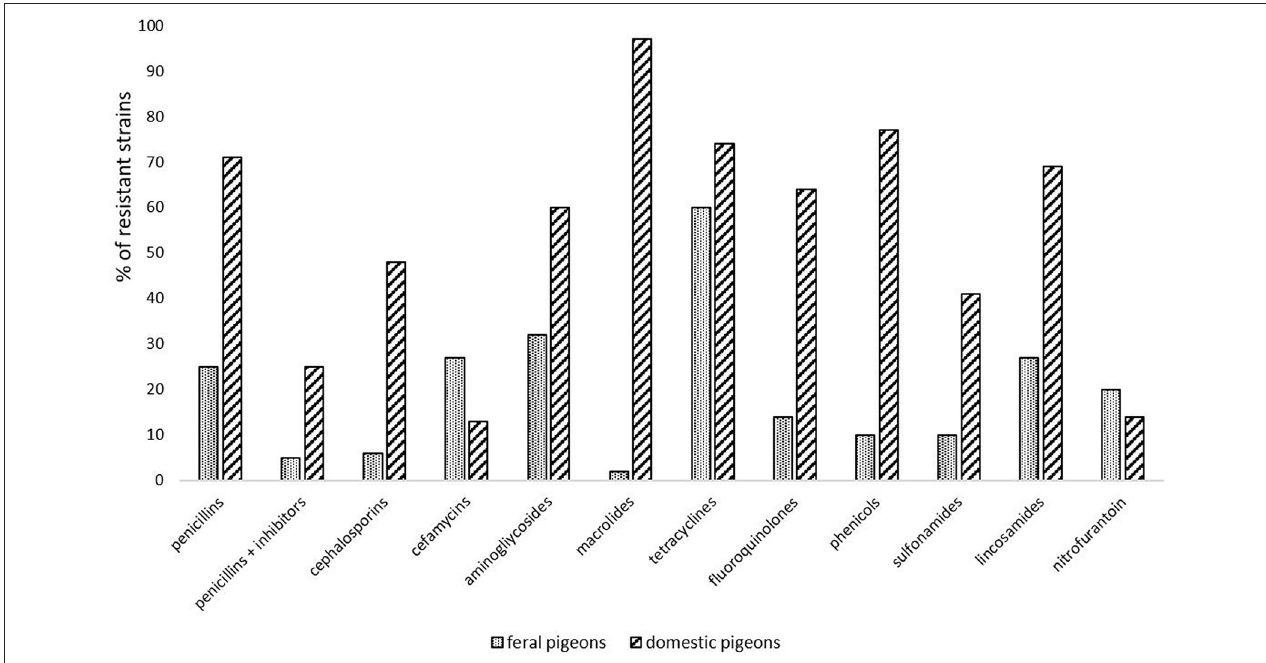
FIGURE 2 | Comparison of antimicrobial resistance in E. coli strains isolated from feral and domestic pigeons, according to publications available in the PubMed database ( 18, 21–30).